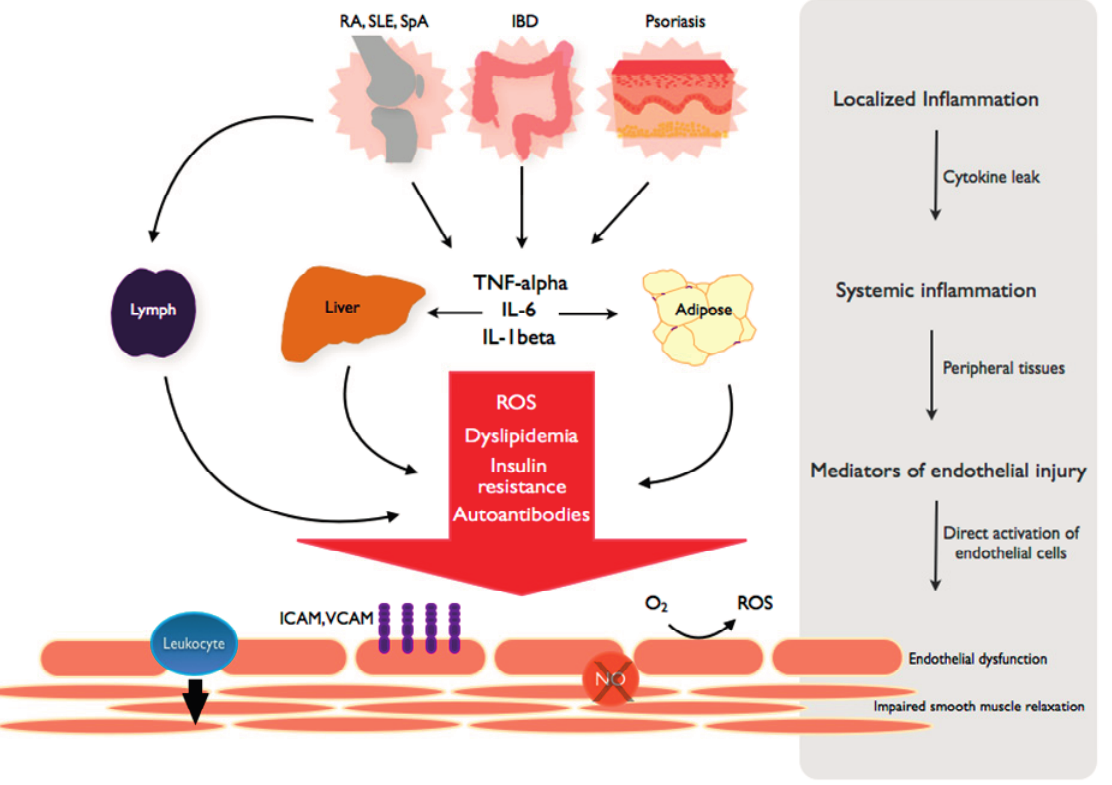
Figure 2. From local inflammation to systemic endothelial dysfunction. TNF and inflammatory cytokines spread from the primary, disease-specific site of local inflammation into the systemic circulation to propagate a systemic inflammatory response. The byproducts of systemic inflammation, including reactive oxygen species (ROS), lipid abnormalities and other metabolic derangements are dependent on peripheral tissues such as the liver and adipose. These mediators elicit independent and complementary effects on the endothelium, leading to a state of endothelial dysfunction characterized by increased adhesion molecule expression (VCAM, ICAM), leukocyte diapedesis, ROS production and decreased NO (nitric oxide)-mediated smooth muscle relaxation and vascular dilation. Autoantibodies are generated in a disease-specific manner and induce similar changes